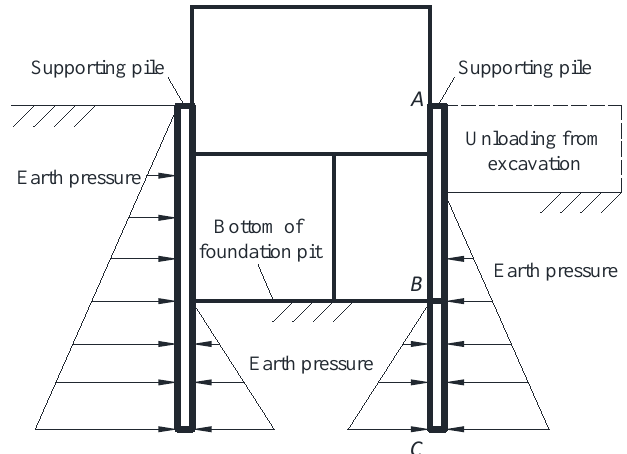
Figure 8. The force analysis of supporting pile.